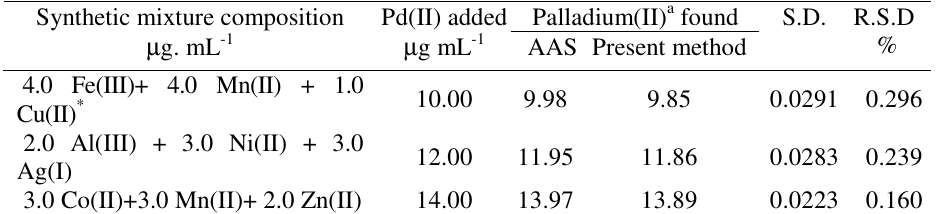
Table 3. Determination of Palladium in synthetic